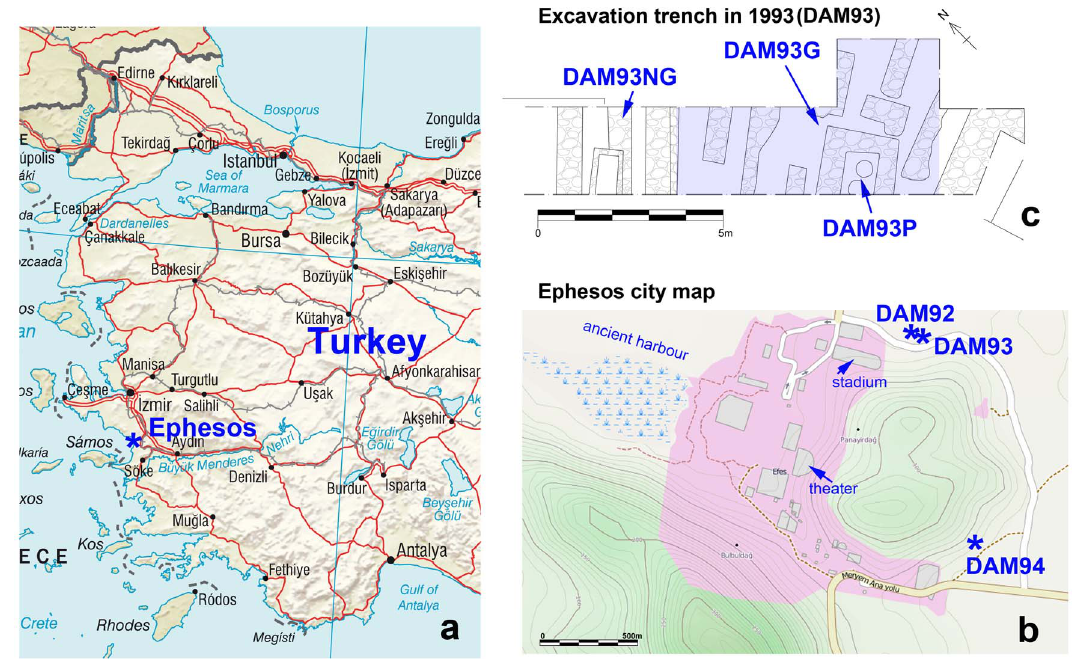
Figure 1. Study area at the west coast of Turkey. (a) Geographical location of ancient Ephesus. (b) City map of Roman Ephesus with investigated excavations sites. (c) Details of the excavation trench in 1993 (DAM93) including the gladiator cemetery (DAM93G). Images compiled with modified data from OpenStreetMap and CIA maps.